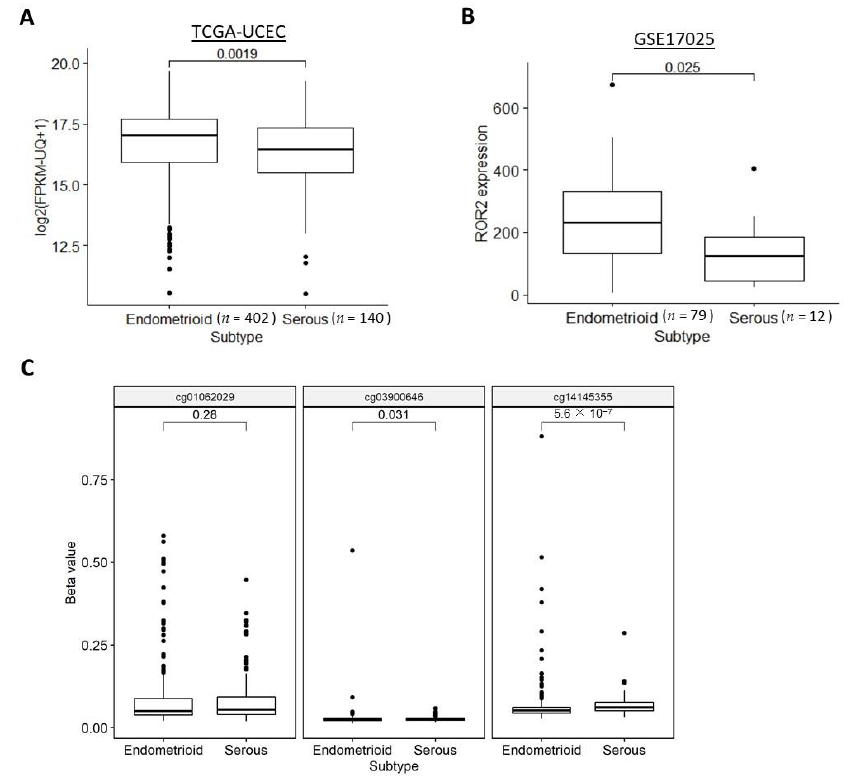
Figure 3. ROR2 mRNA expression level was downregulated in serous EC due to hypermethylation of ROR2 promoter region in the TCGA-UCEC and GSE17025 datasets. ( A ): ROR2 expression level was significantly higher in endometrioid compared to serous EC in TCGA-UCEC ( p = 0.002). ( B ): ROR2 expression level was significantly higher in endometrioid compared to serous EC in GSE17025 ( p = 0.025). ( C ): Methylation level of both cg03900646 and cg14145355 in the ROR2 promoter was significantly different between serous and endometrioid EC ( p = 0.031, p < 0.001 respectively).